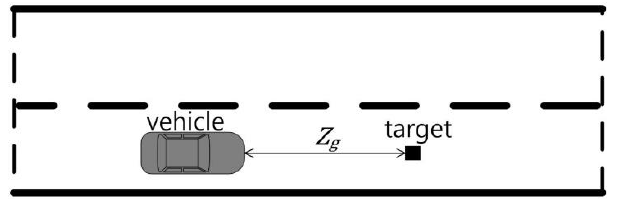
Figure 12. Distance to the object in front of the vehicle on a straight road.